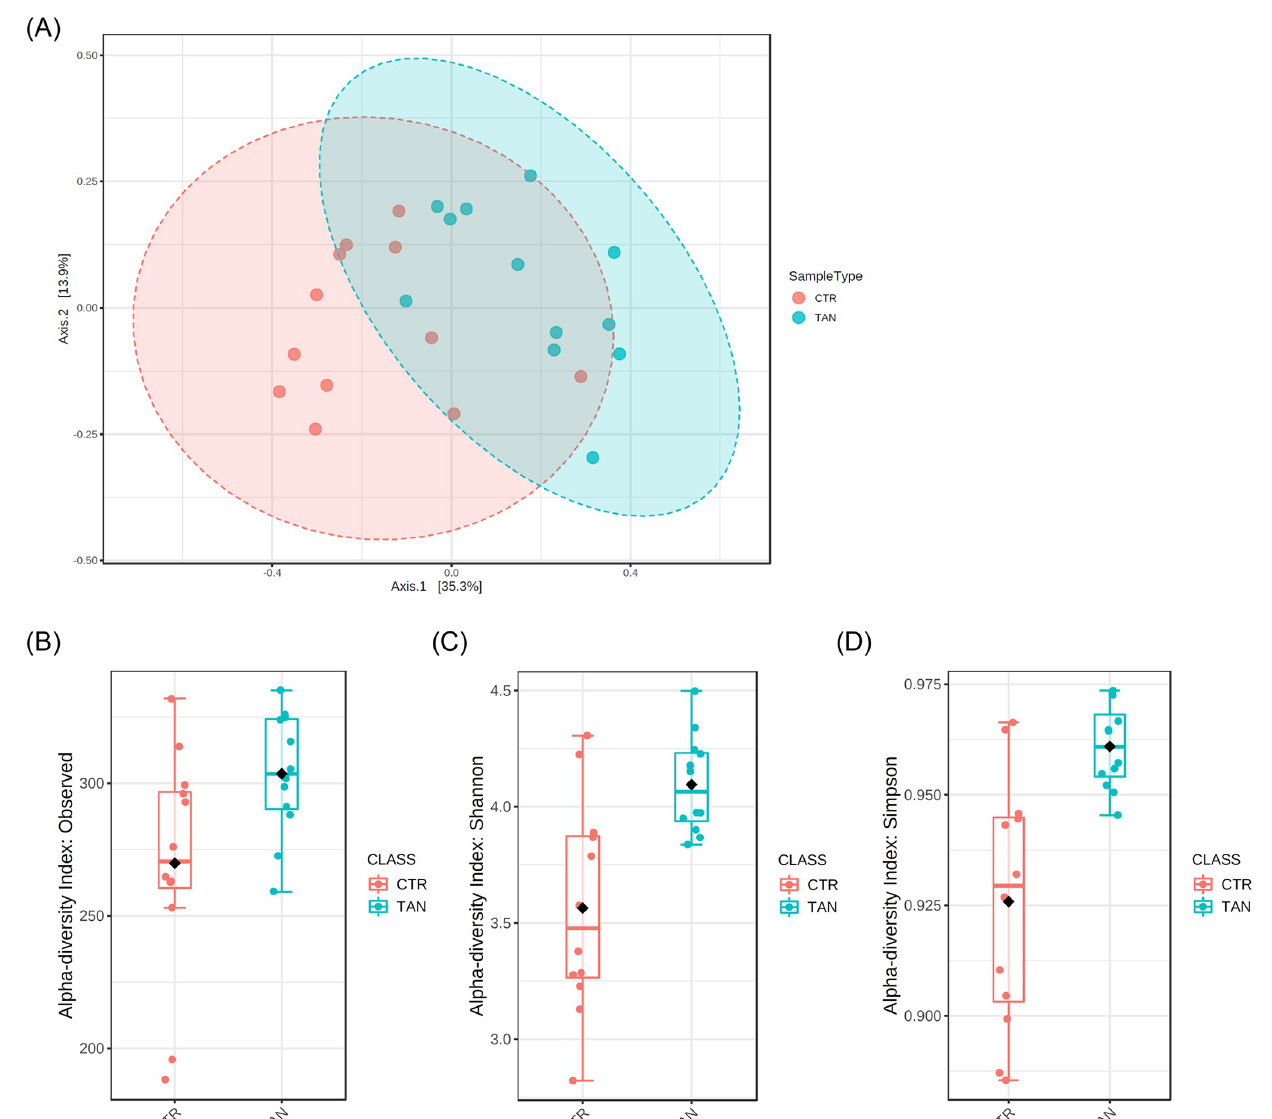
Fig 1. (A) Principal coordinate analysis (PCoA) plot based on Bray–Curtis distances of the intestinal microbial communities of weaning piglets fed on a diet with tannin (TAN) and the control group receiving a basal diet (CTR). (B) Observed species index (p = 0.03), (C) Shannon index (p = 0.02), and (D) Simpson index (p = 0.001). The index values are graphically presented by box plots, each of which represents the interquartile range, whereas the line inside the box represents the